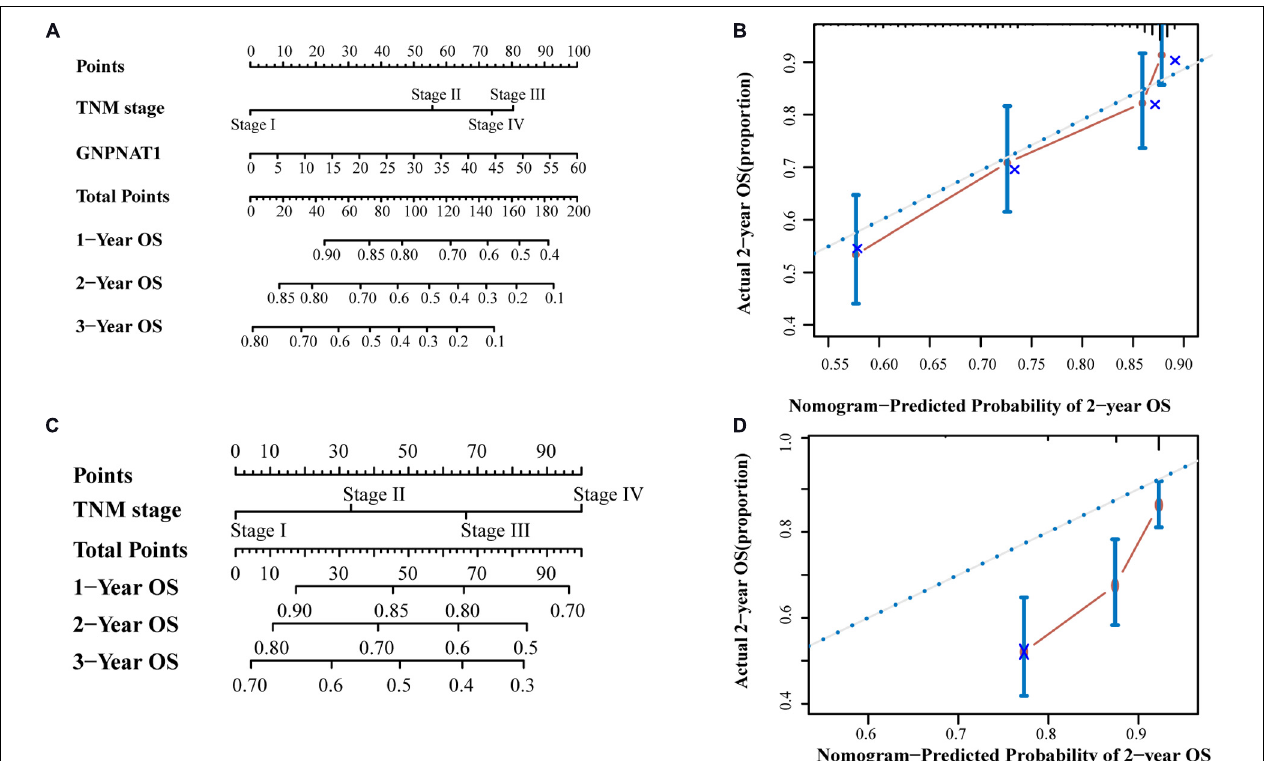
FIGURE 5 | The prognostic nomograms based on GNPNAT1 and TNM stage (A) and TNM stage alone (C) . The calibration curve of (A) nomogram for predicting OS at 2 year (B) . The calibration curve of (C) nomogram for predicting OS at 2 year (D) .